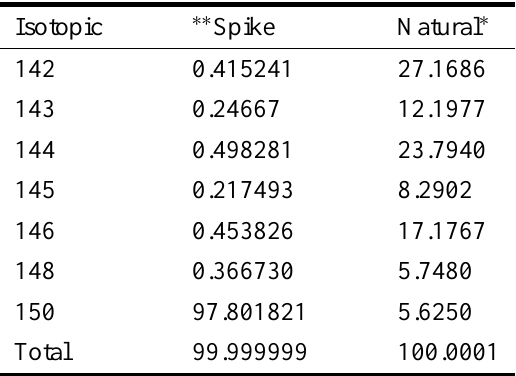
Isotopic Abundance for Nd ( %